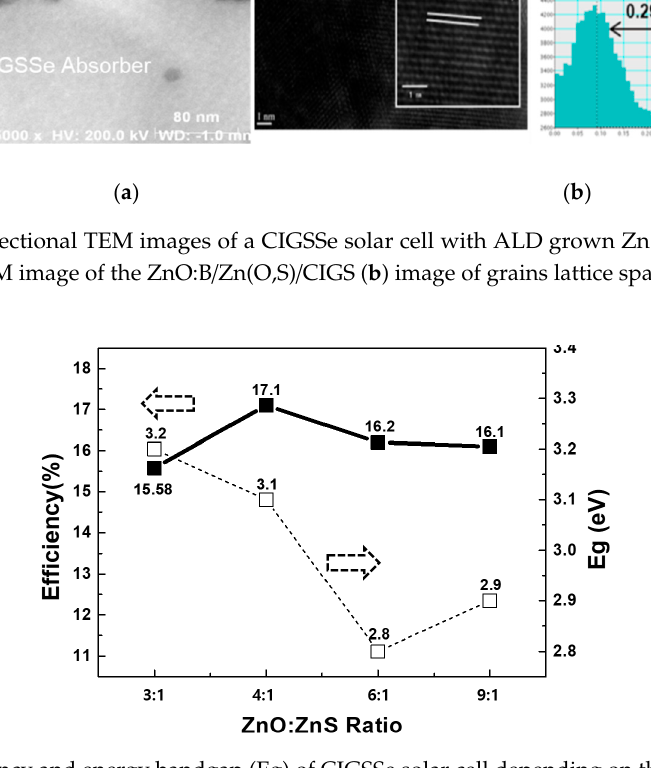
Figure 2. Cross-sectional TEM images of a CIGSSe solar cell with ALD grown Zn(O,S) buffer layer. ( a ) Magnified TEM image of the ZnO:B/Zn(O,S)/CIGS ( b ) image of grains lattice spacing